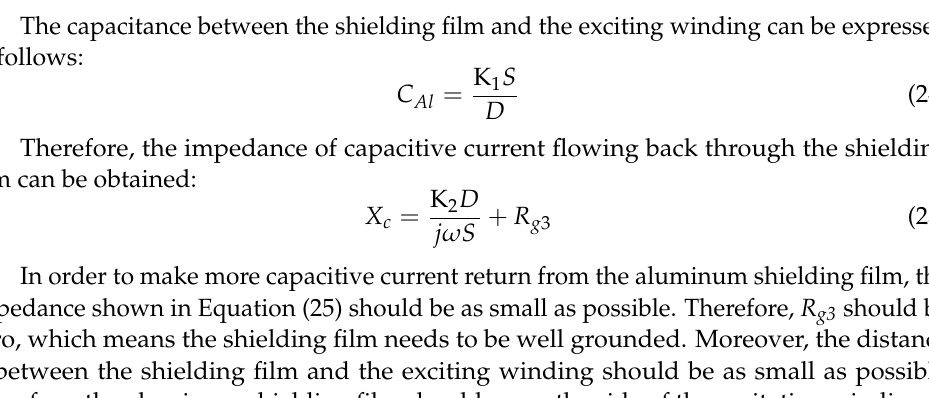
Figure 8. Capacitance network model with shielding film.